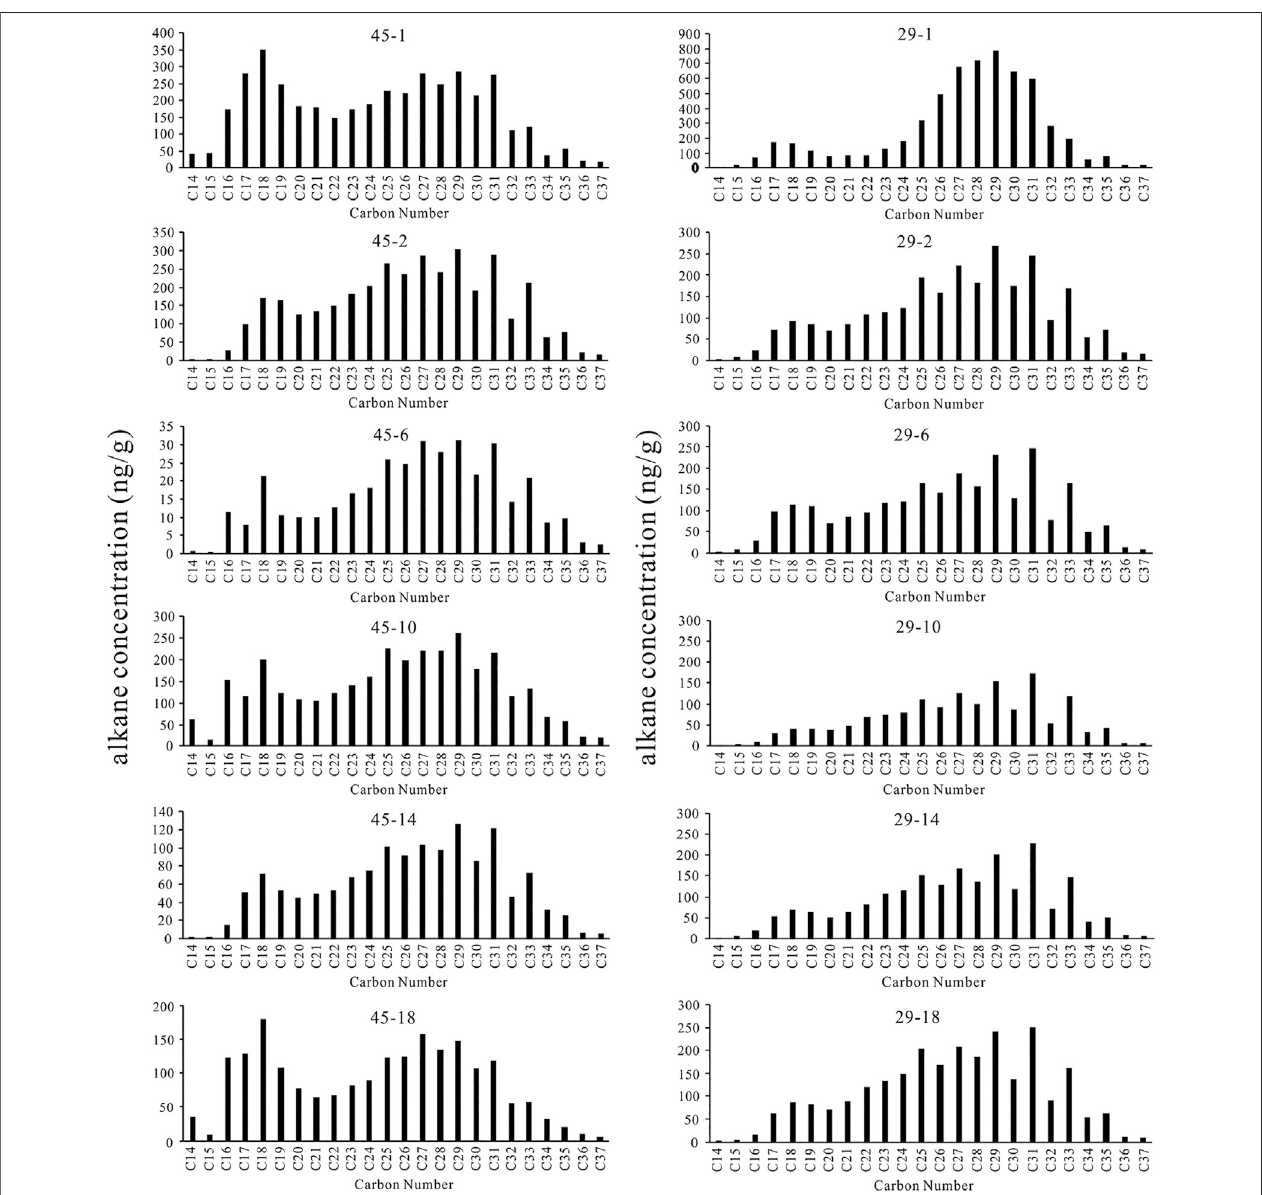
FIGURE 3 | The distribution of n -alkanes by carbon number in core